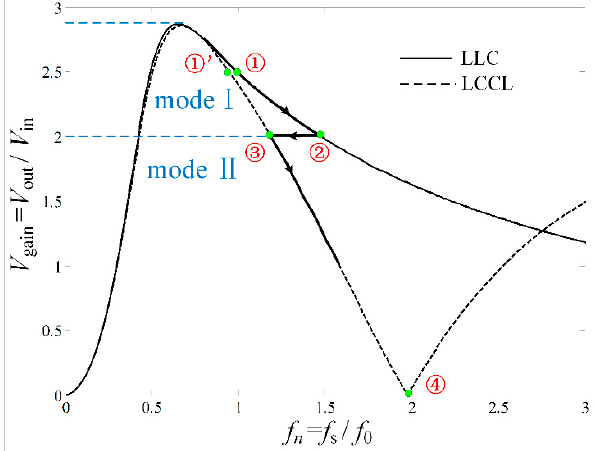
Figure 12. The expected gain curve of the proposed